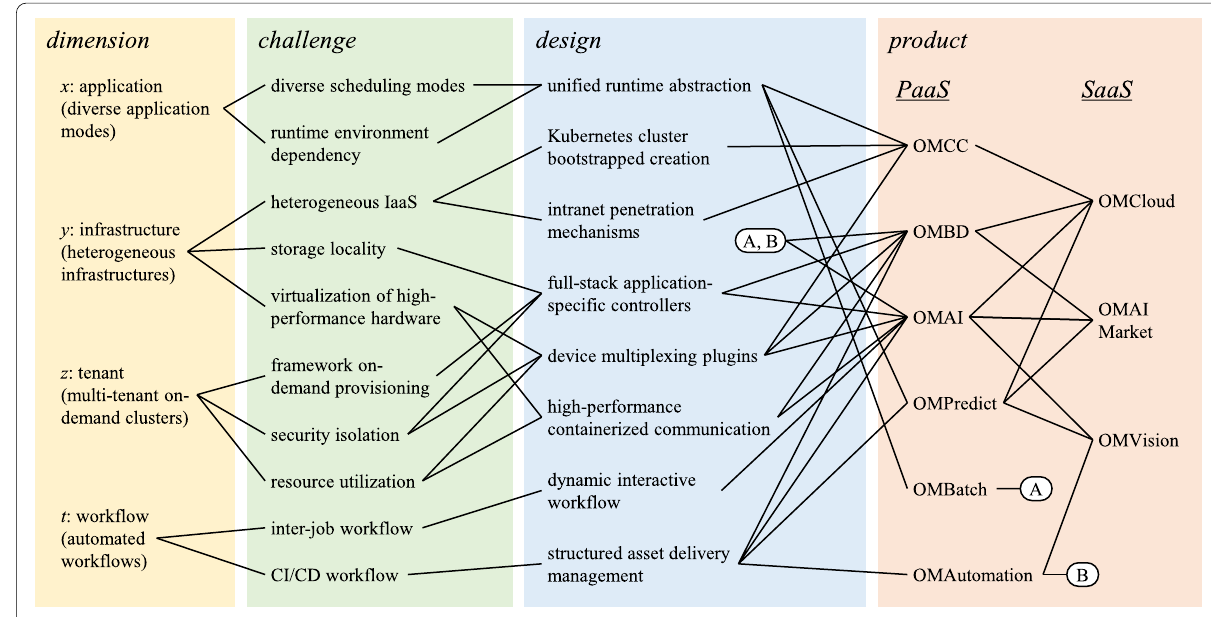
Fig. 3 The designs of key technologies and the challenges they